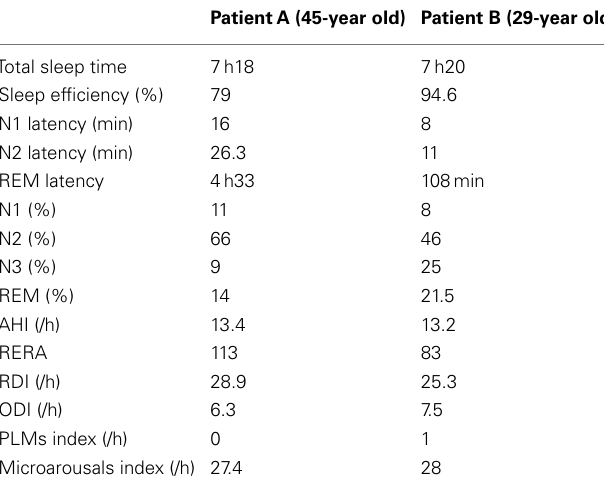
Table 1 | Sleep scoring results for the two